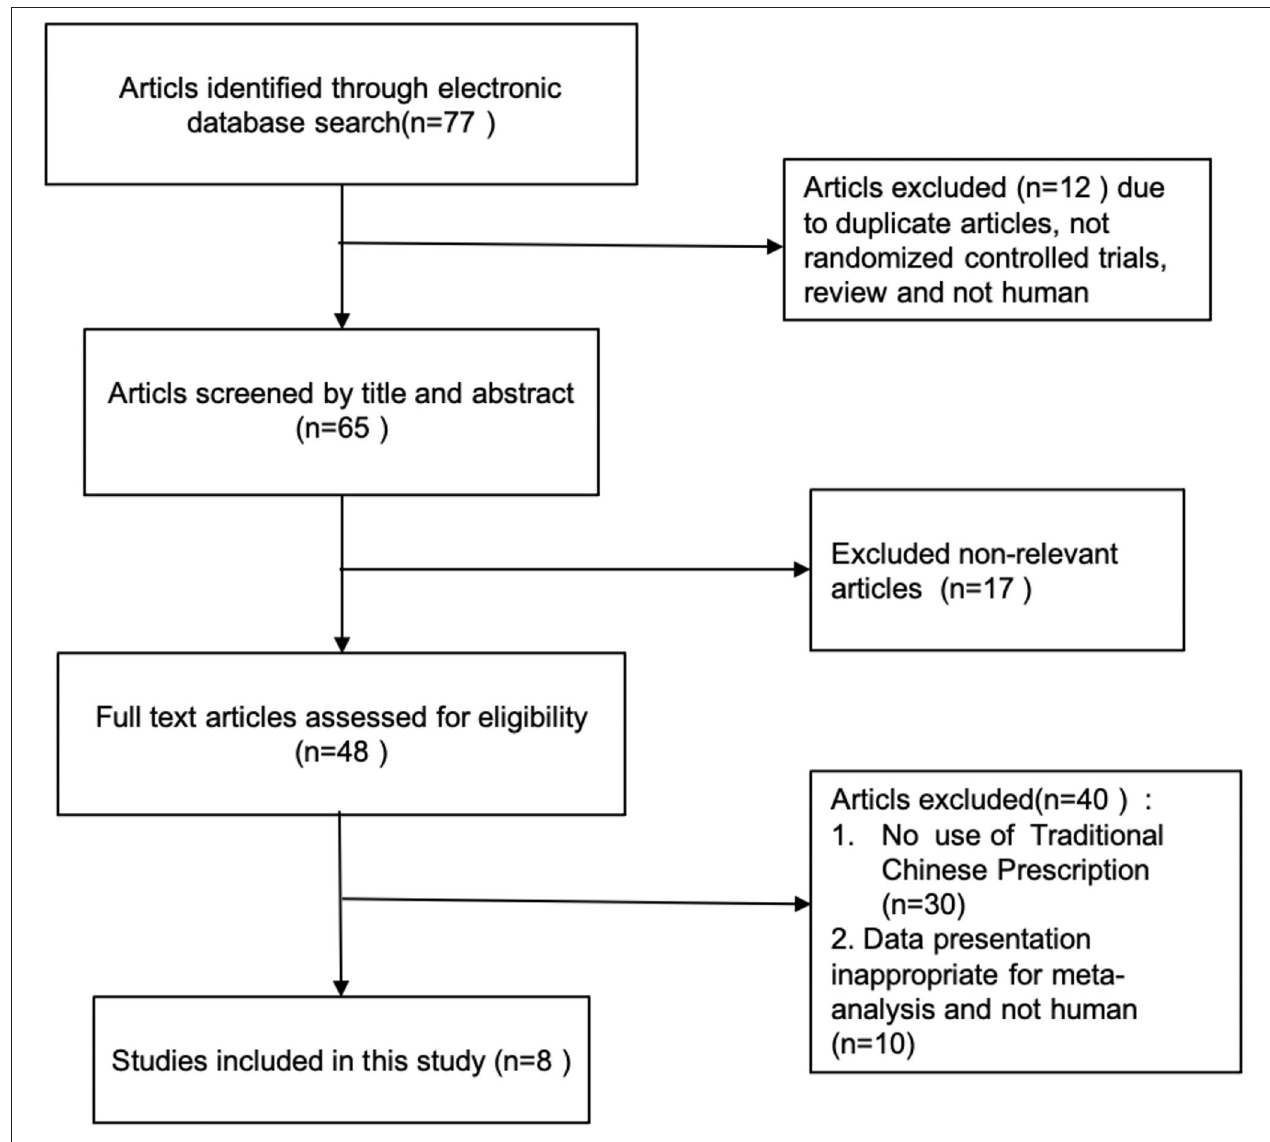
FIGURE 1 | Flowchart of literature